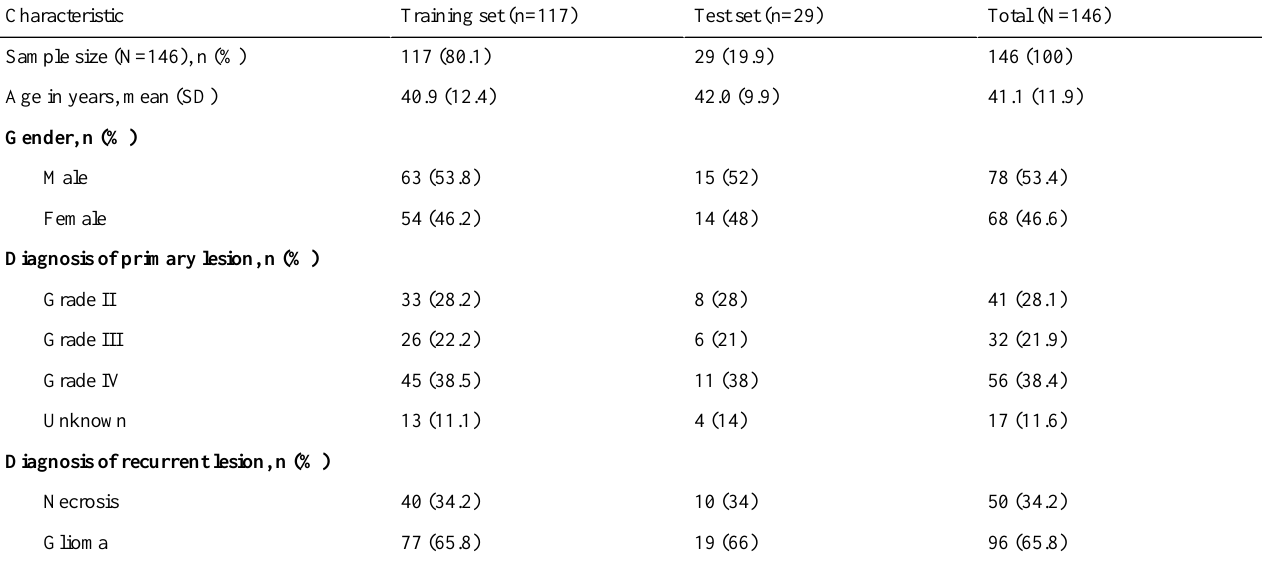
Table 1. Demographic and clinical data of the patient cohorts enrolled in this study.